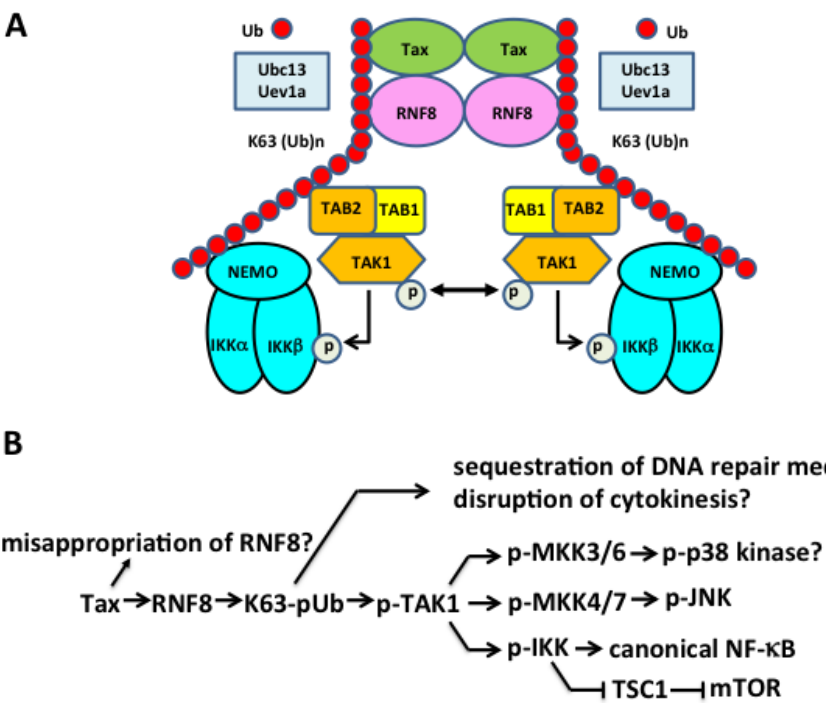
Figure 2. Tax hijacks the ubiquitin E3 ligase, ring finger protein 8 ( RNF8) and E2 conjugating enzyme UBC13: Uev1A/Uev2 to activate transforming growth factor beta (TGFβ)-activated kinase 1 ( TAK1), I kappa B kinase (IKK), canonical NF-κB and other signaling pathways. ( A ) Tax directly